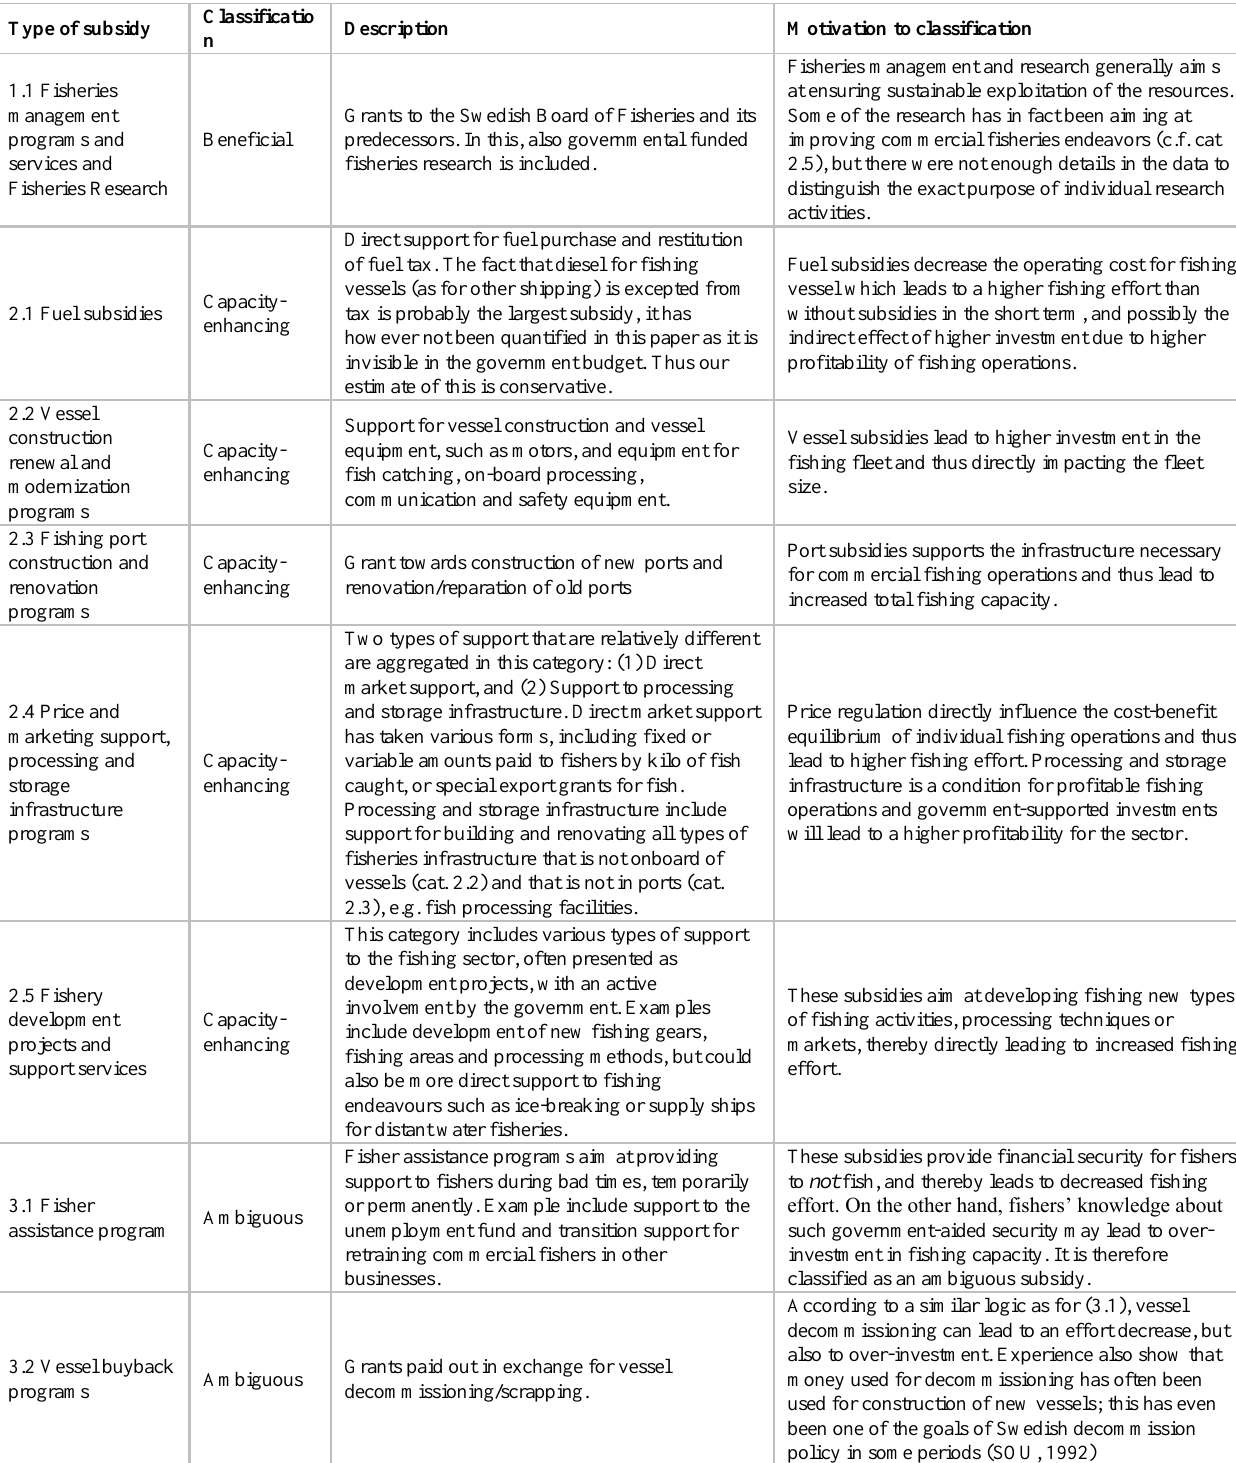
Table A1.1. Types of subsidies to given to Swedish fisheries, and classification following (Sumaila et al., 2010), description and motivation of the classification. See also Appendix Tables A1.1 and A1.2 with a complete list of all subsidies reported in Swedish budget proposals and from EU structural grants, respectively, and for which years they apply. We combined the two beneficial subsidy categories (1.1) Fisheries management and (1.2) Fishery research into one category, because research activities were often reported as a part of the management activities and thus not tractable through the whole